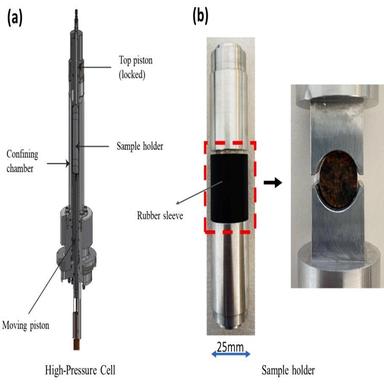
A), a schematic of the high-pressure cell for the fragmentation test, which is mounted on the ct scanner; the moving piston, connected to a pid controlled hydraulic syringe pump, exerts vertical compression to the sample in sample holder; b) a picture of the aluminium sample holder with a magnified view of the jaws holding a rock plug.